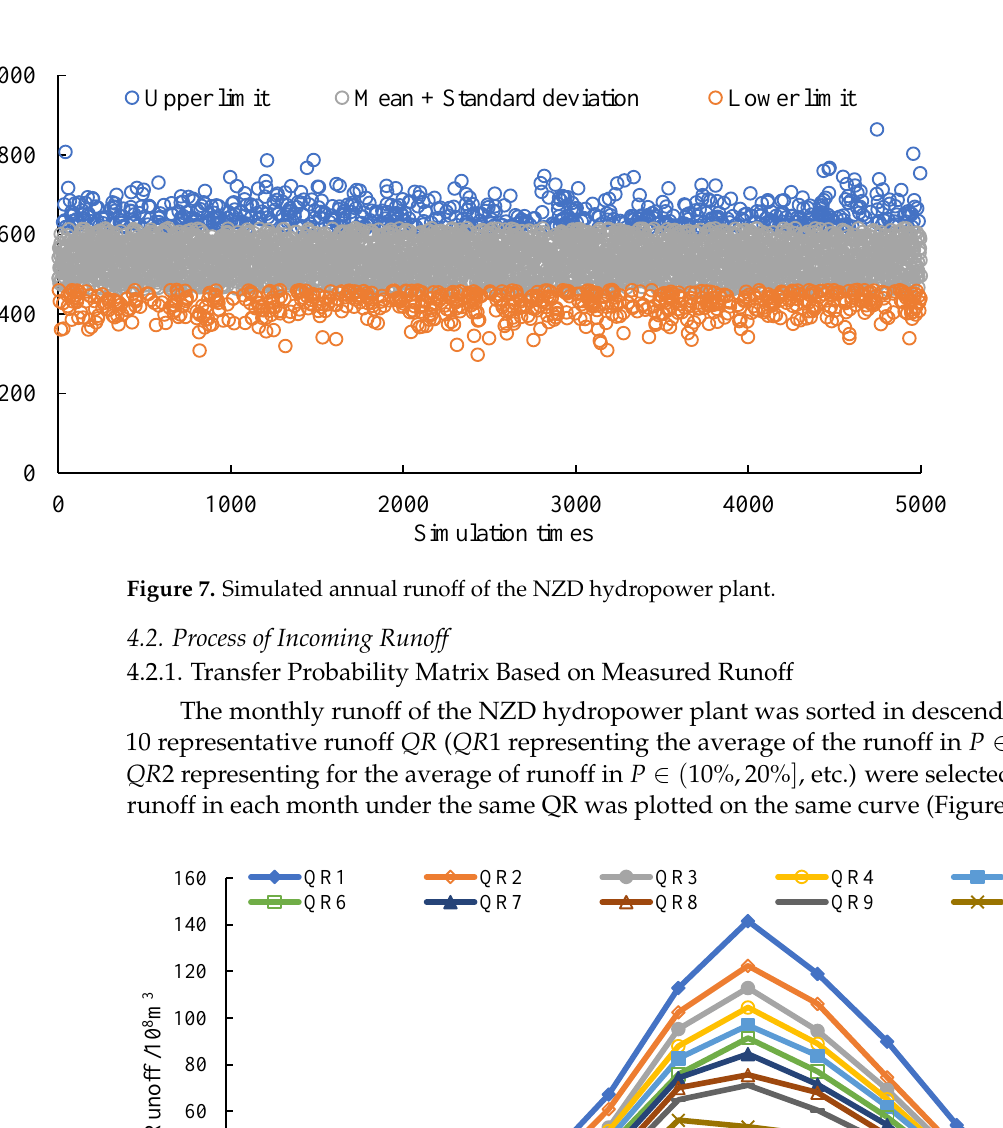
Figure 6. Observed and simulated monthly inflow of the NZD hydropower plant.